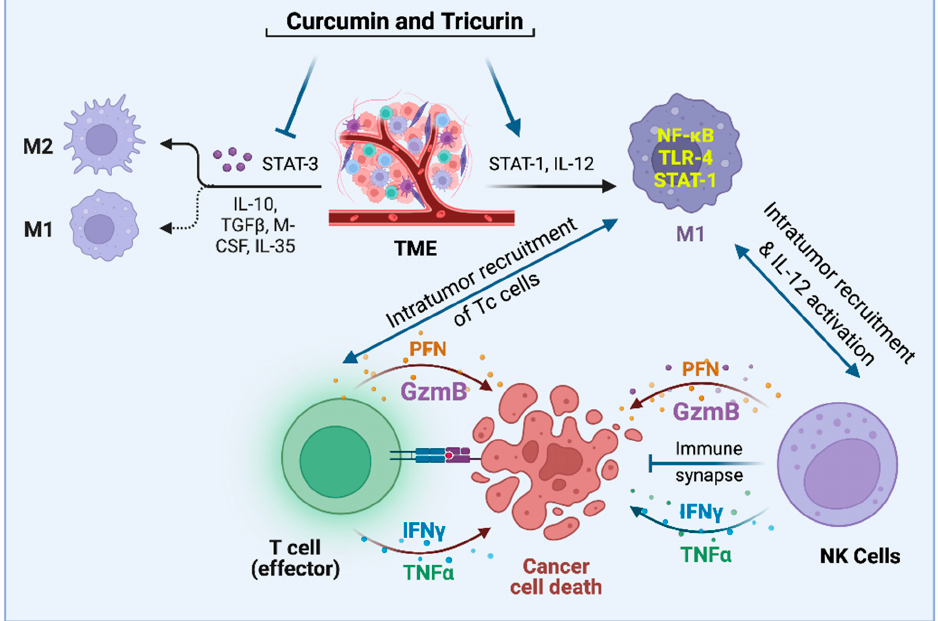
Figure 1. Pleiotropic natural agents topple the STAT-3/STAT-1 balance in the TAMs and recruit NK and Tc cells into the TME, thus launching an attack on tumor cells and tumor stem cells